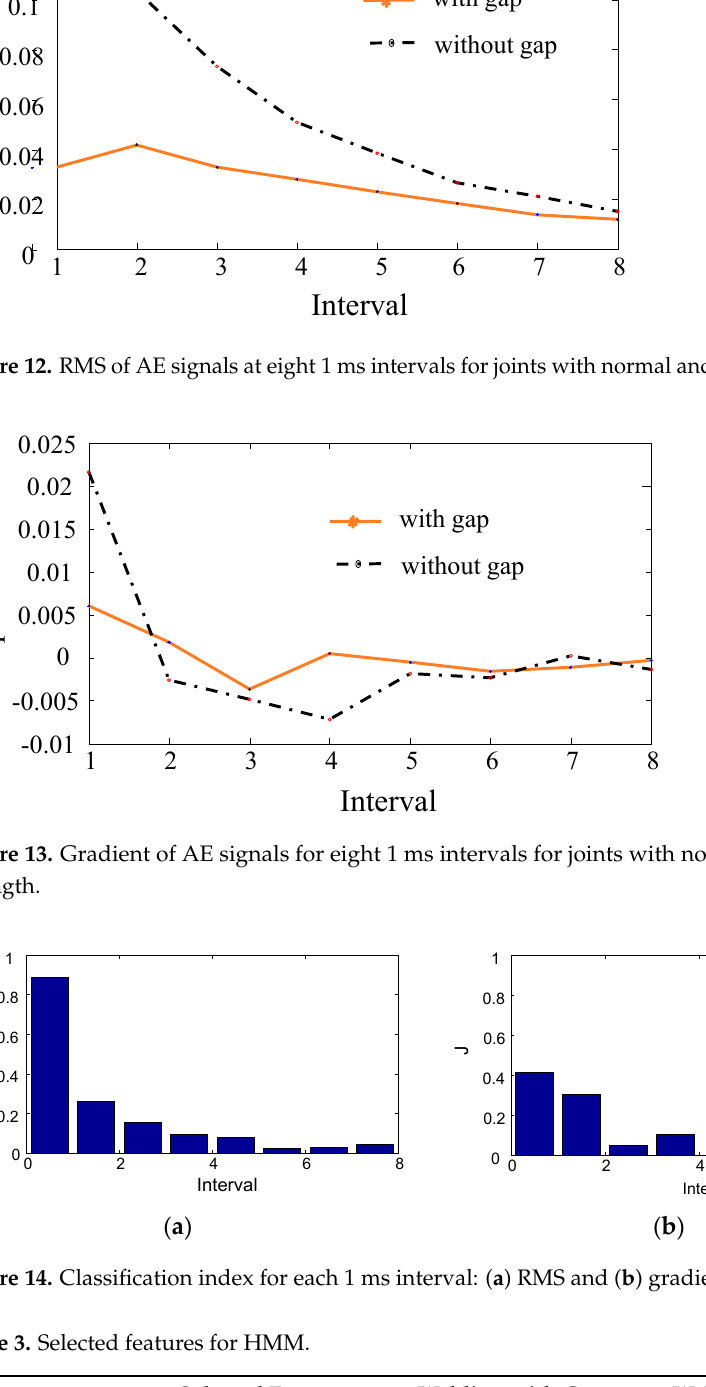
Figure 12. RMS of AE signals at eight 1 ms intervals for joints with normal and low bonding strength .